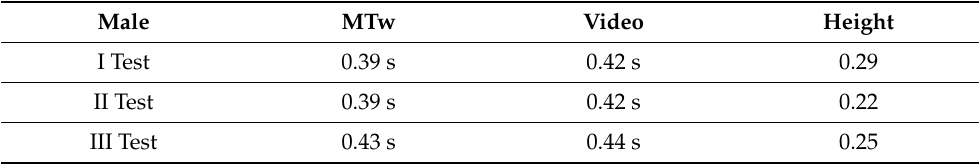
Table 3. Comparison between the time of flight (s) obtained by analyzing the sensors’ data and by the video frame data. The resulting jump height is in meters. Male MTw Video